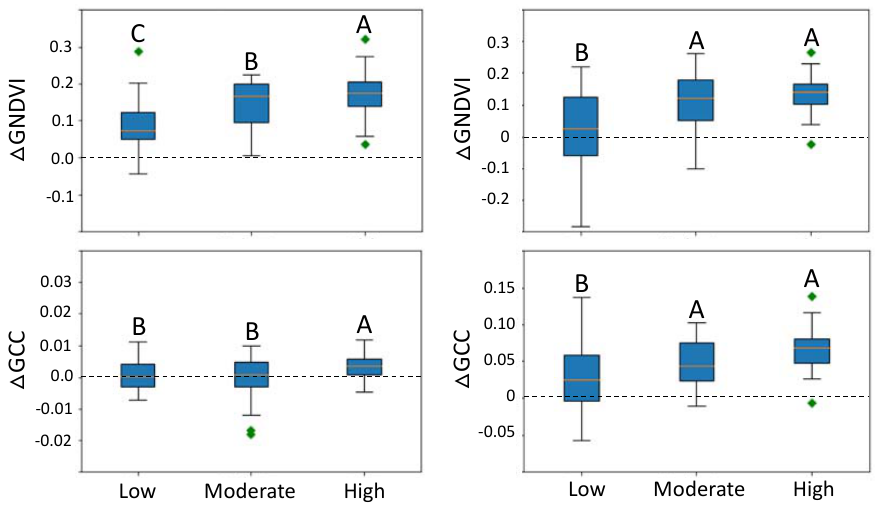
Figure 6 . Boxplots of ∆ VI in areas classified in field as low, moderate and highly burned. ∆ GNVI, ∆ NDVI, and GCC were derived from Planet and Sentinel-2A images. Different letters signify statistically different means ( p < 0.05) using one ‐ way ANOVA followed by Tuckey HSD separation procedure.